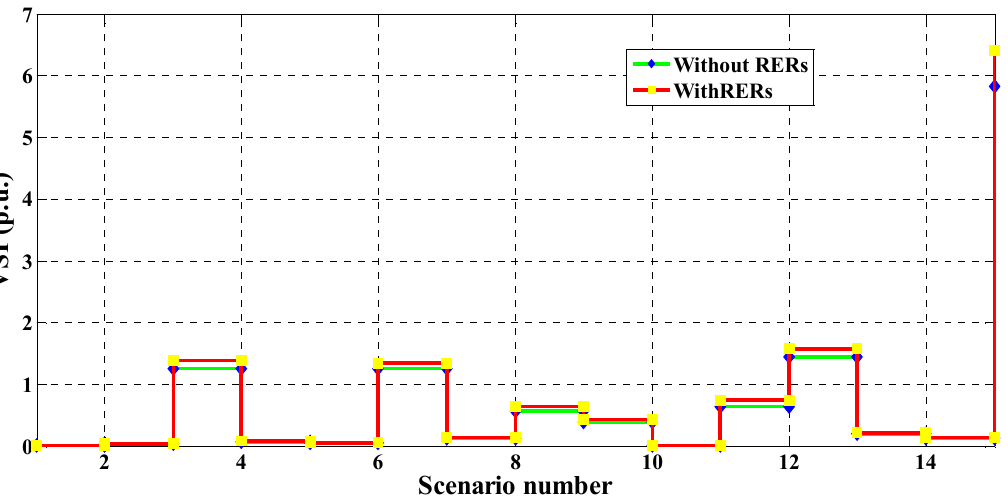
Figure 22. The 15-bus system VDs.